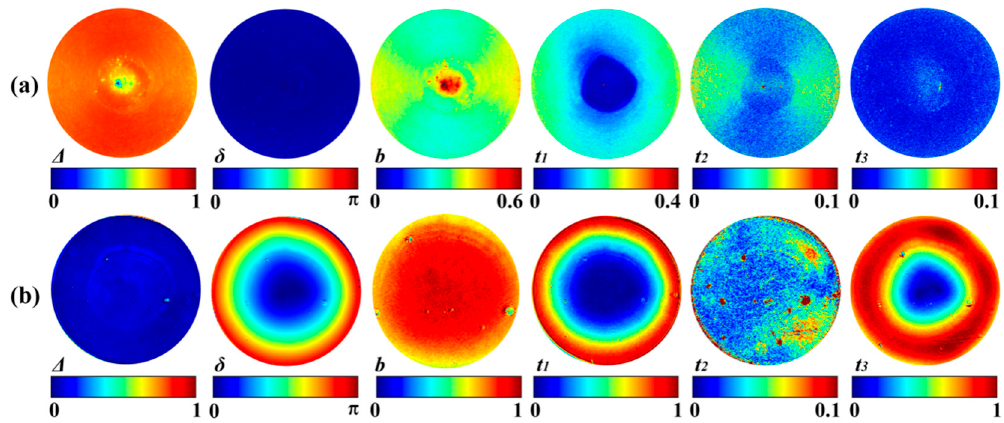
Figure 3. Mueller matrix derived parameters of the samples: ( a ) Mueller matrix polar decomposition (MMPD) and Mueller matrix transformation (MMT) parameters of the silk phantom. ( b ) MMPD and MMT parameters of the GRIN lens. Since the m14 values for both samples are close to 0 (Figure 2a–d), the images of D (not shown) and t 2 are almost the same.